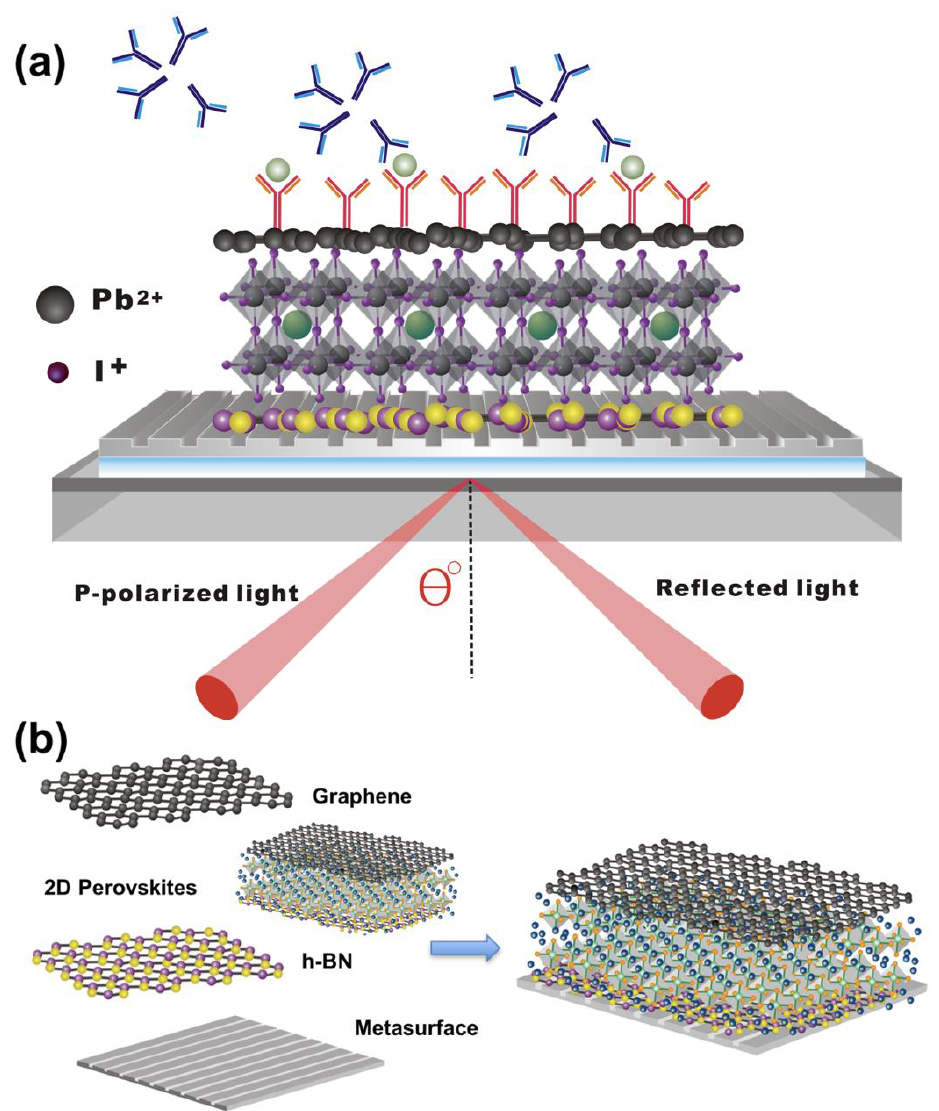
Figure 1. ( a ) Schematic figure of a 2D perovskite-based Goos–Hänchen enhanced surface plasmon resonance (GH-SPR) biosensor, which is integrated with metasurface patterns; ( b ) graphene/2D perovskite/hBN engineered on metasurface patterns.